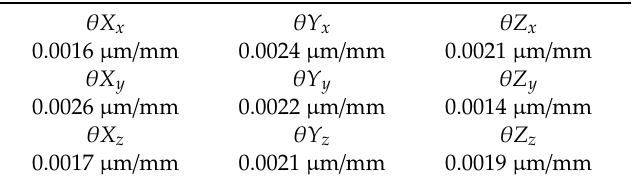
Table 4. Angle errors of the machine